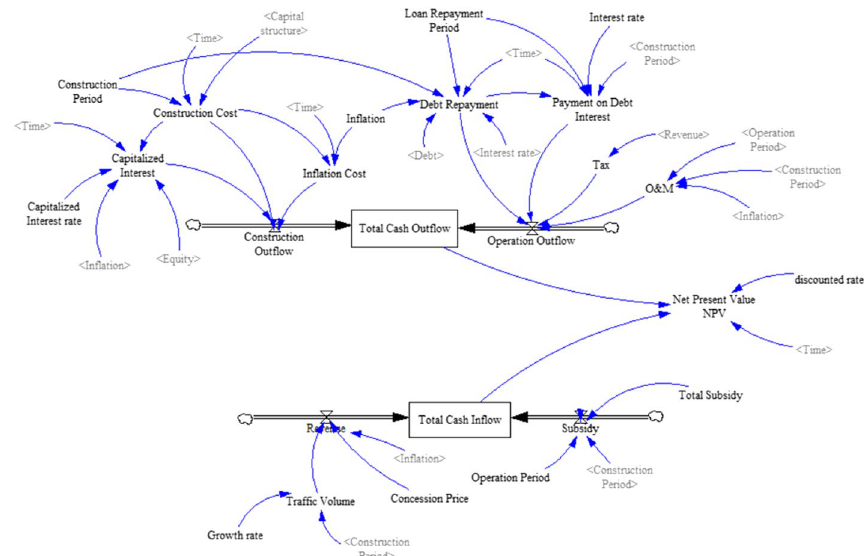
Fig. 6 Stock and flow diagram for the net present value